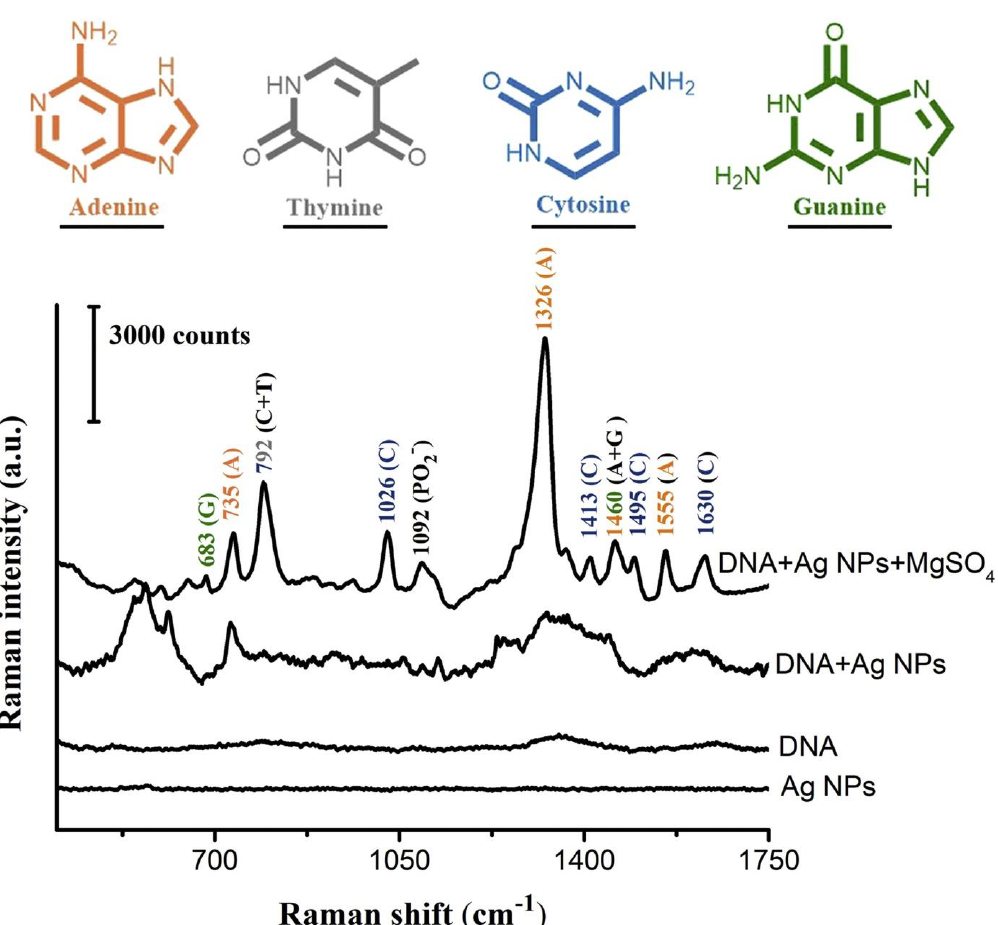
Figure 5. Comparison of surface-enhanced Raman spectroscopy (SERS) spectra of Ag nanoparticles (NPs), DNA, DNA + Ag NPs and DNA + Ag NPs + MgSO 4 . Intensities of Raman peaks allow quantitative analysis of nucleobase content in DNA molecule with PO 2 signal as reference. Reprinted from [172] with permission from Elsevier.